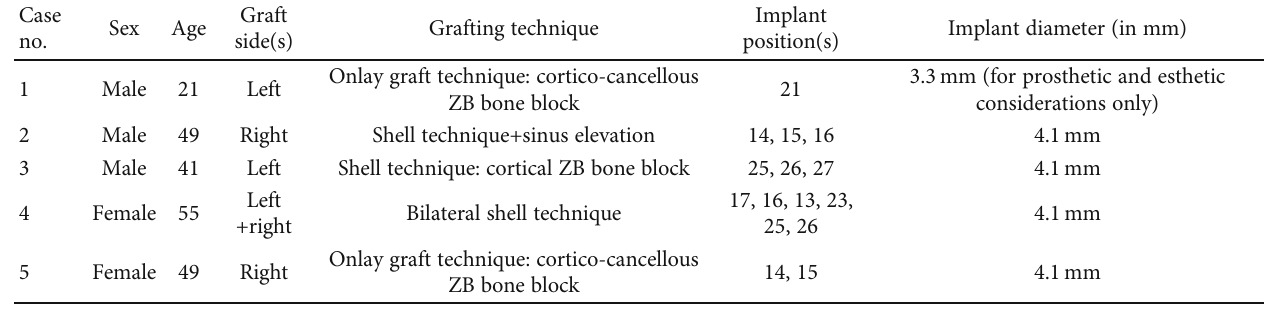
Table 1: Description of each case.